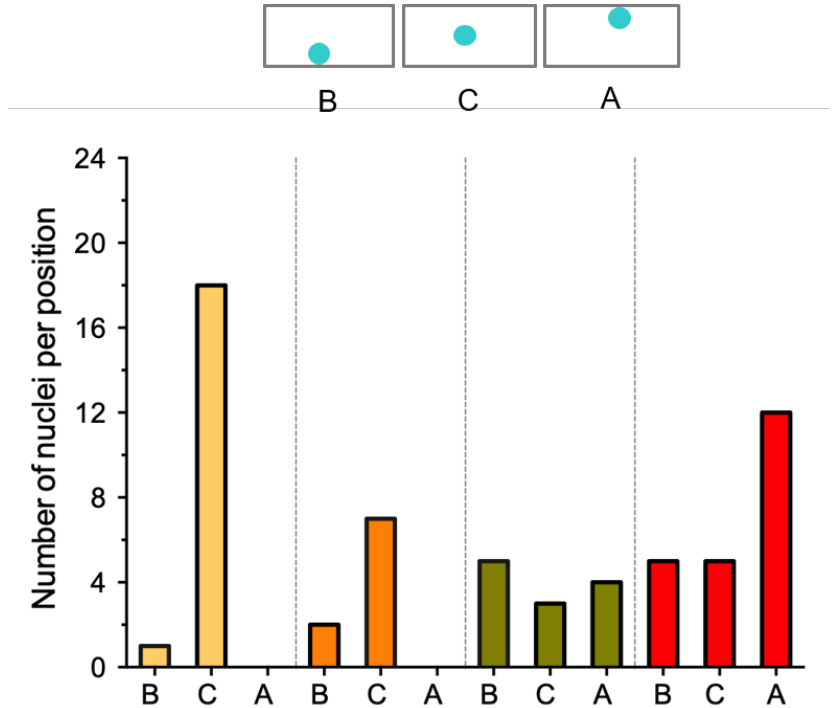
Figure 4. Distribution of the nuclei position in subepidermal (S-E) cells at stages I–IV of the IT progression. Graphic representation of the nuclei position in cells at each of the IT progression stages. Nuclei were either stained with DAPI or expressing NLS-mTurquoise2. Images were captured from 17 independent roots inoculated with R. etli CE3-DsRed pMP604. Number of cells ( n ) analyzed: stage I, n = 19; stage II, n = 9; stage III, n = 12; and stage IV, n = 22. Nuclei from each stage were classified in three groups, depending on their position in the cell: B, basal; C, central and A, apical.